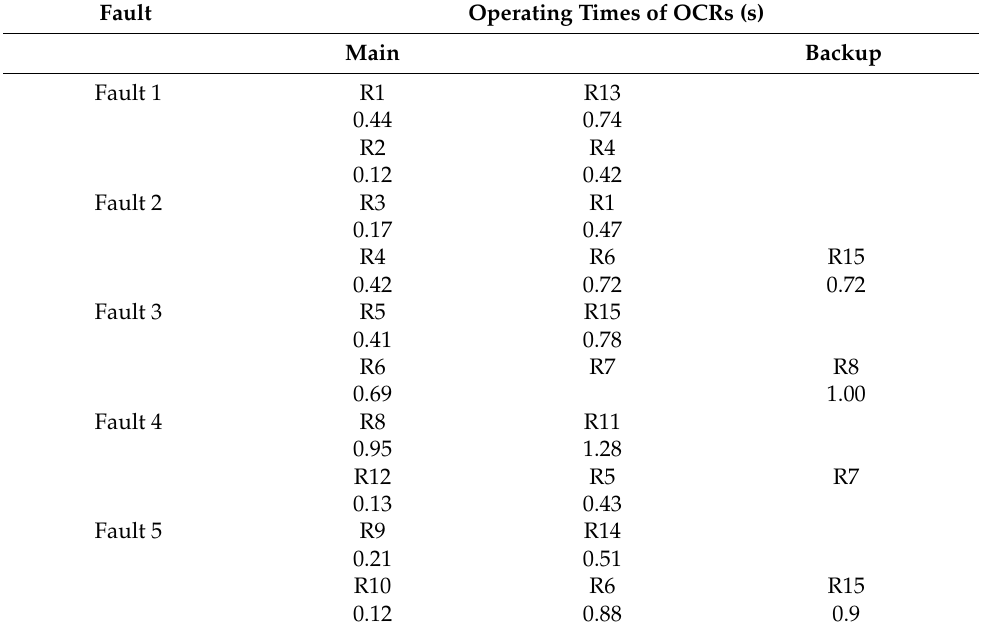
Table 10. Operating times for Scenario